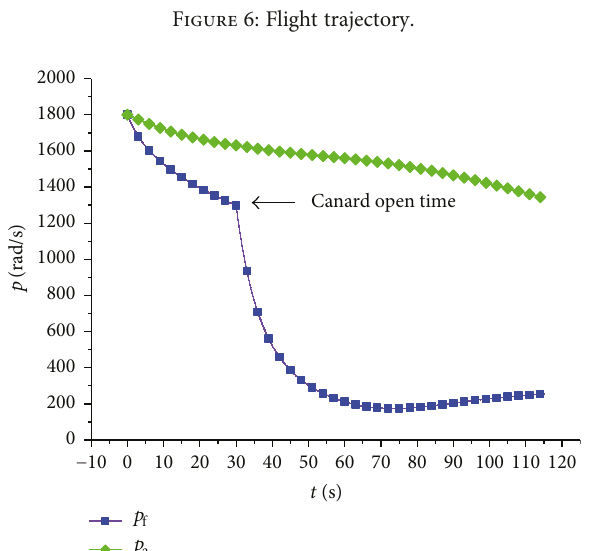
Figure 6: Flight trajectory.